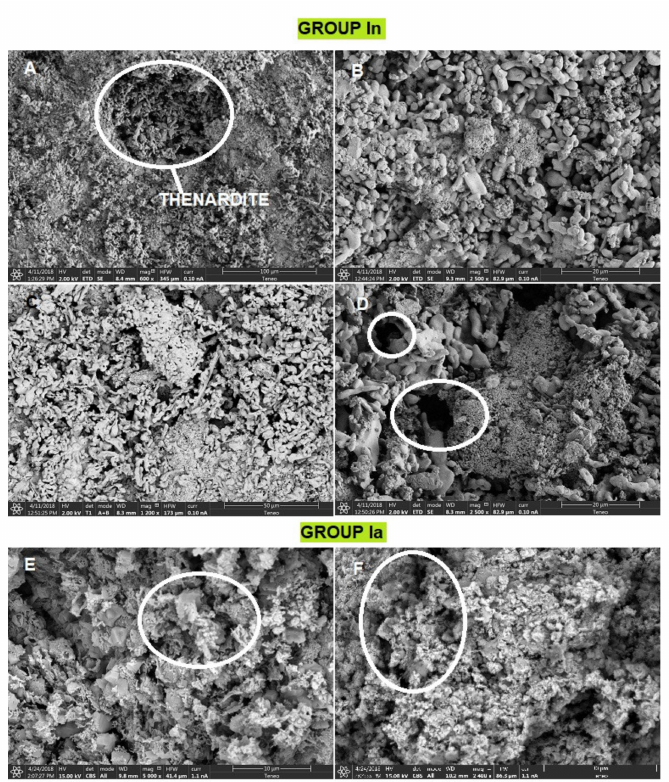
Figure 8. SEM images of group I mortar samples. ( A ) Thenardite crystallizations; ( B ) Detail of thenardite crystal morphology; ( C ) High porosity area; ( D ) Pores with a rounded morphology; ( E ) Carbonate matrix with calcite crystals (~2 µ m); ( F ) Microcrystalline aggregates of calcite that seal pores and